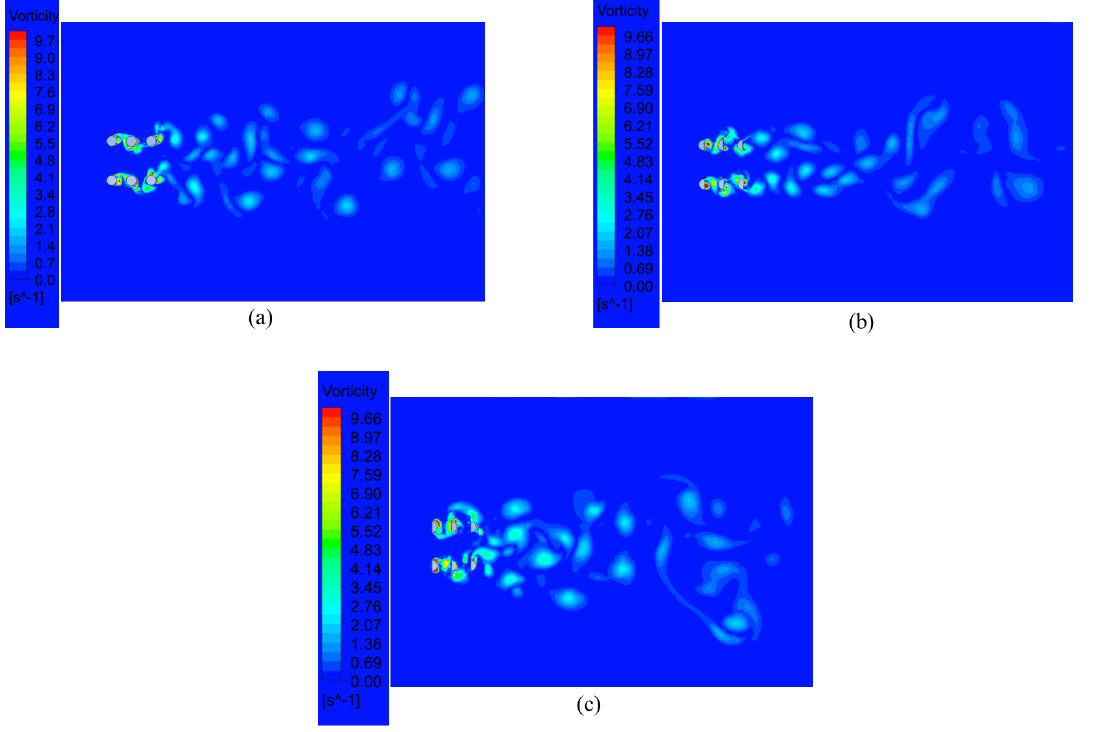
Figure 7. Vorticity contours for the linearly sheared flow simulations at L/D = 2 for the cylinder of a variative cross-section: ( a ) Shape 1; ( b ) Shape 2; ( c ) Shape